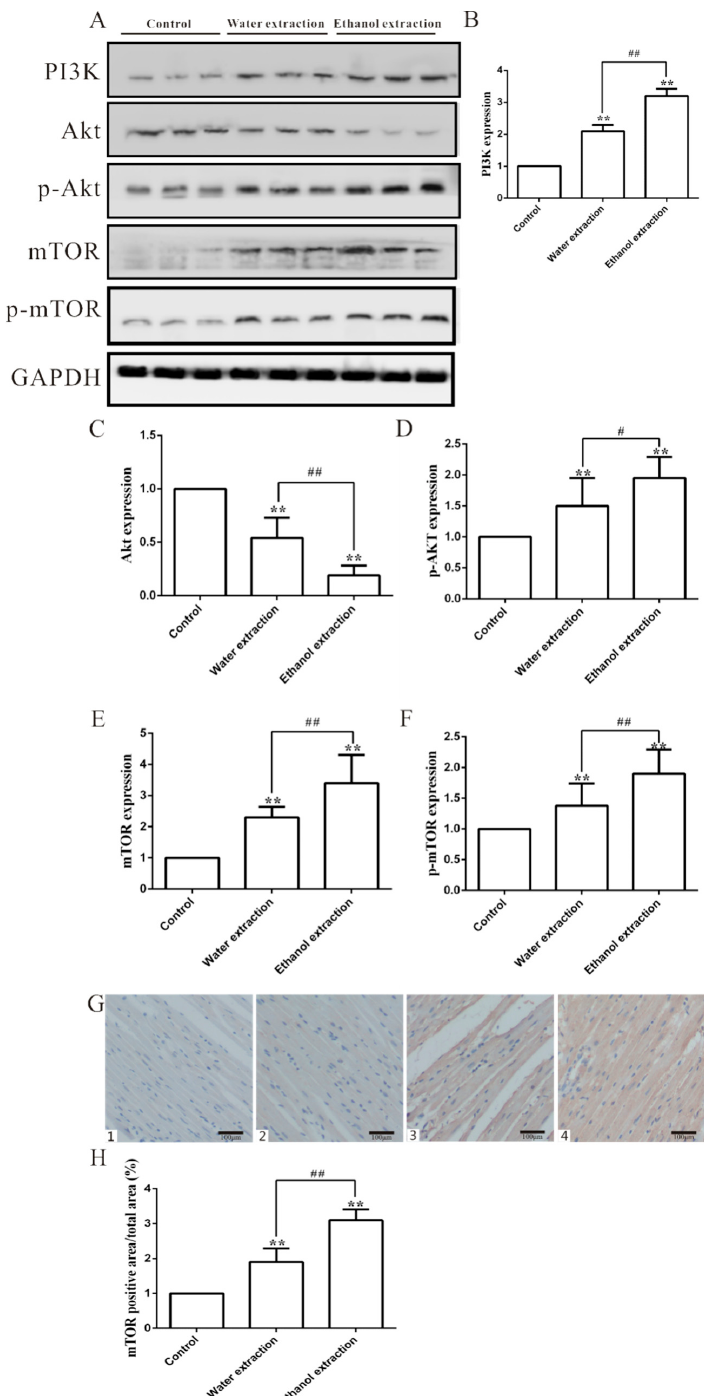
Figure 8. The PI3K/Akt/mTOR expression levels in the heart tissues in control, water extraction, and ethanol extraction groups. ( A ) PI3K, Akt, p-Akt, mTOR, and p-mTOR protein expression levels; ( B – F ) Quantitative analyses of PI3K, Akt, p-Akt, mTOR, and p-mTOR protein ( n = 3); ( G ) Representative figure of mTOR immunohistological staining in heart (200 × ); 1: Negative group; 2: Control group; 3: Water extract group; 4: Ethanol extract group; ( H ) Statistic results of mTOR immunohistological staining ( n = 8); GAPDH: glyceraldehyde-3-phosphate dehydrogenase; The protein expression levels were determined by Western blot analyses and relative band intensities were analyzed by the Image J software; data are expressed as mean ± SD. ** p < 0.01 vs. control group; # p < 0.05, ## p < 0.01 vs. water extraction